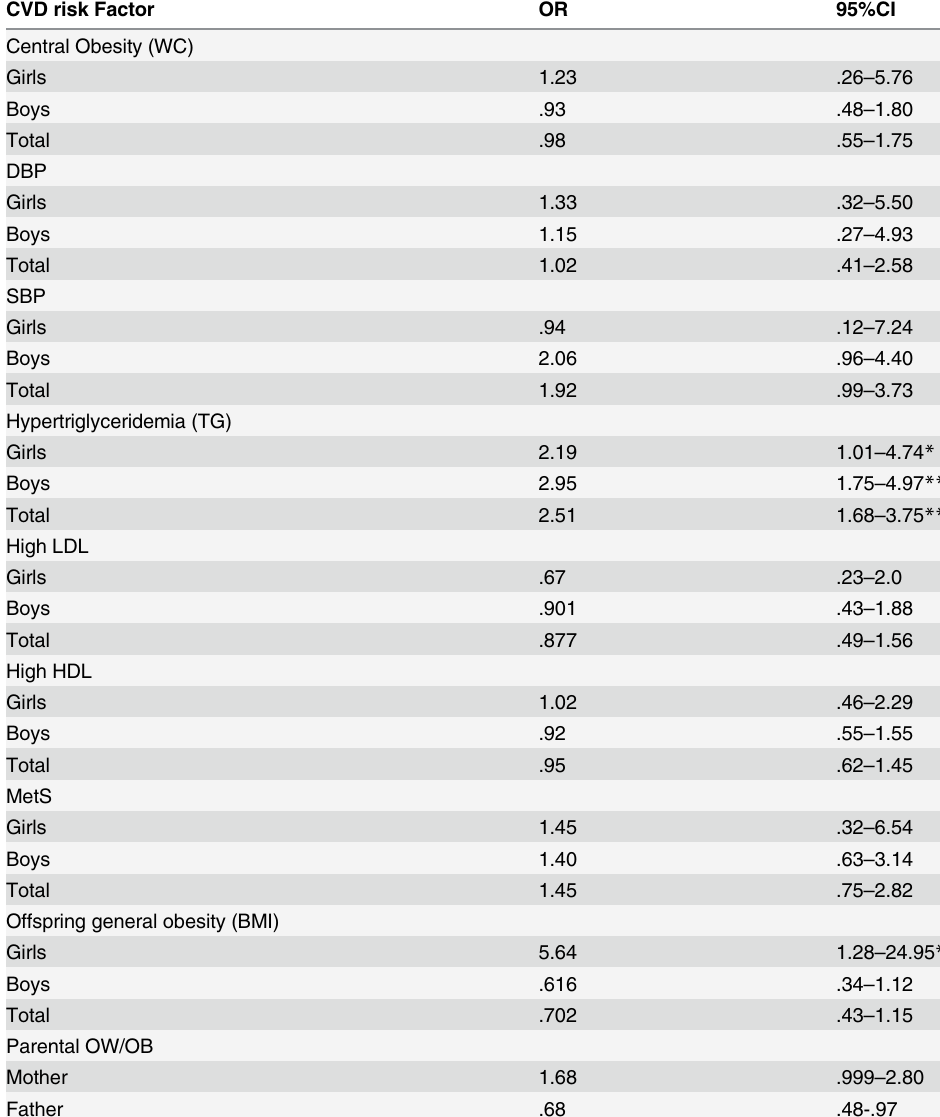
Table 3. Associations between location and CVD